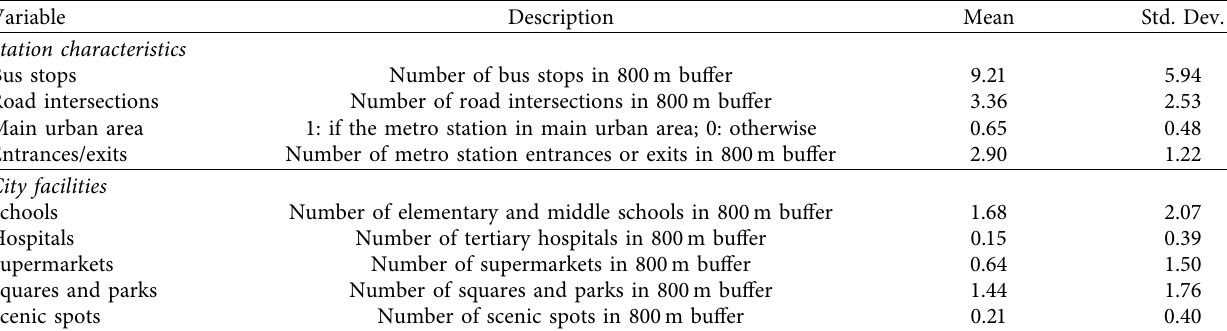
Table 1: Descriptive statistics of variables.